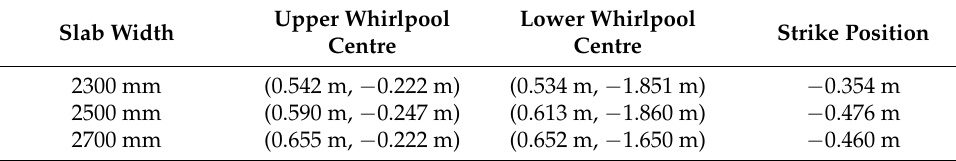
Figure 14. Fluid contours: ( a ) trajectory line; and ( b ) flow field at a 2700 mm width. Table 5. Whirlpool core positions and strike locations under different slab